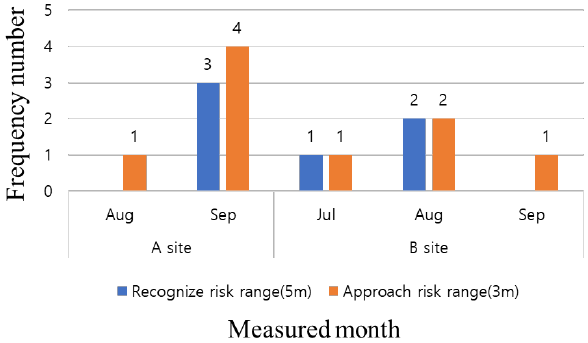
Figure 11. Analysis of heavy equipment access (HEA) sensor data for test beds.